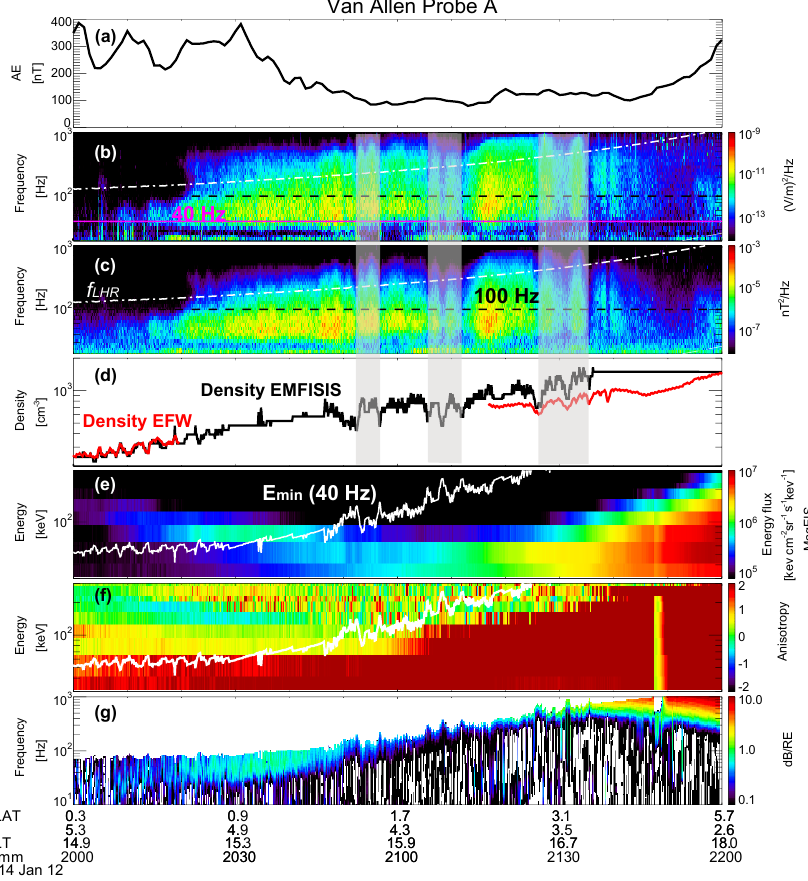
Figure 6. The observation of waves and electron fluxes by Van Allen Probe A during the same period as that in Fig. 1. (a) AE index; (b) frequency-time spectrogram of wave electric field and (c) wave magnetic spectral density in the WFR channel; (d) plasma density obtained by EFW (red) and EMFISIS (black); (e) spin-averaged electron flux measured by MagEIS; (f) electron pitch angle anisotropy; (g) convective wave growth rates. Grey block areas indicate the intervals of hiss modulation by variation of plasma density. The magenta line in (b) indicates 40Hz. The black dashed line in (c) indicates 100Hz. The white lines in (e, f) represent the minimum resonant energy of electrons for the waves at